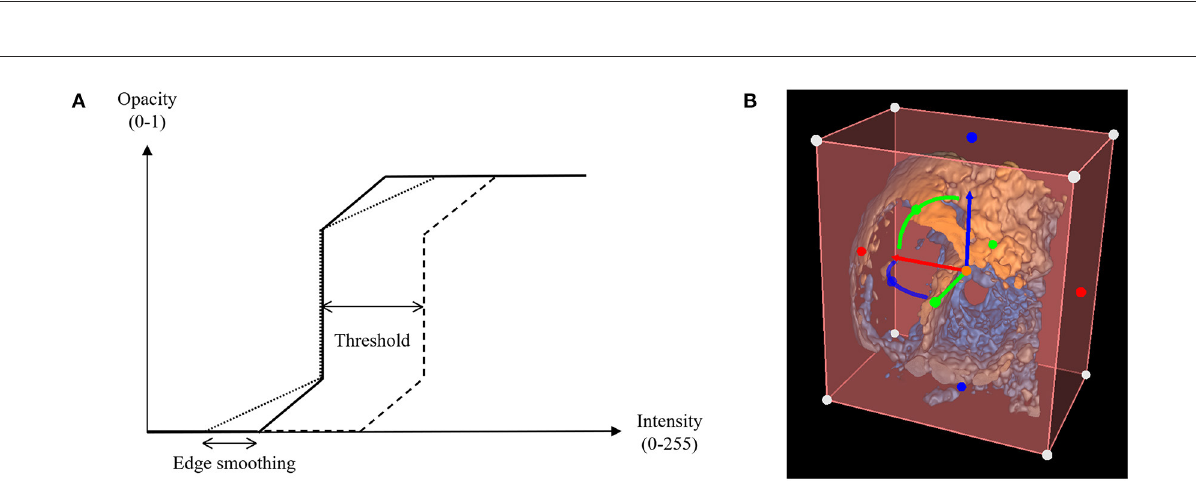
FIGURE2 Threshold and edge smoothing parameters for changes in opacity. (A) Opacity is shown as a function of voxel intensity, where voxels having an intensity value greater than the upper limit appear completely opaque and voxels with an intensity value inferior to the lower limit appear invisible, having a zero-opacity value (see Appendix); (B) Selection of a Region of Interest (ROI) to enable cropping of the rendered 3D echocardiographic